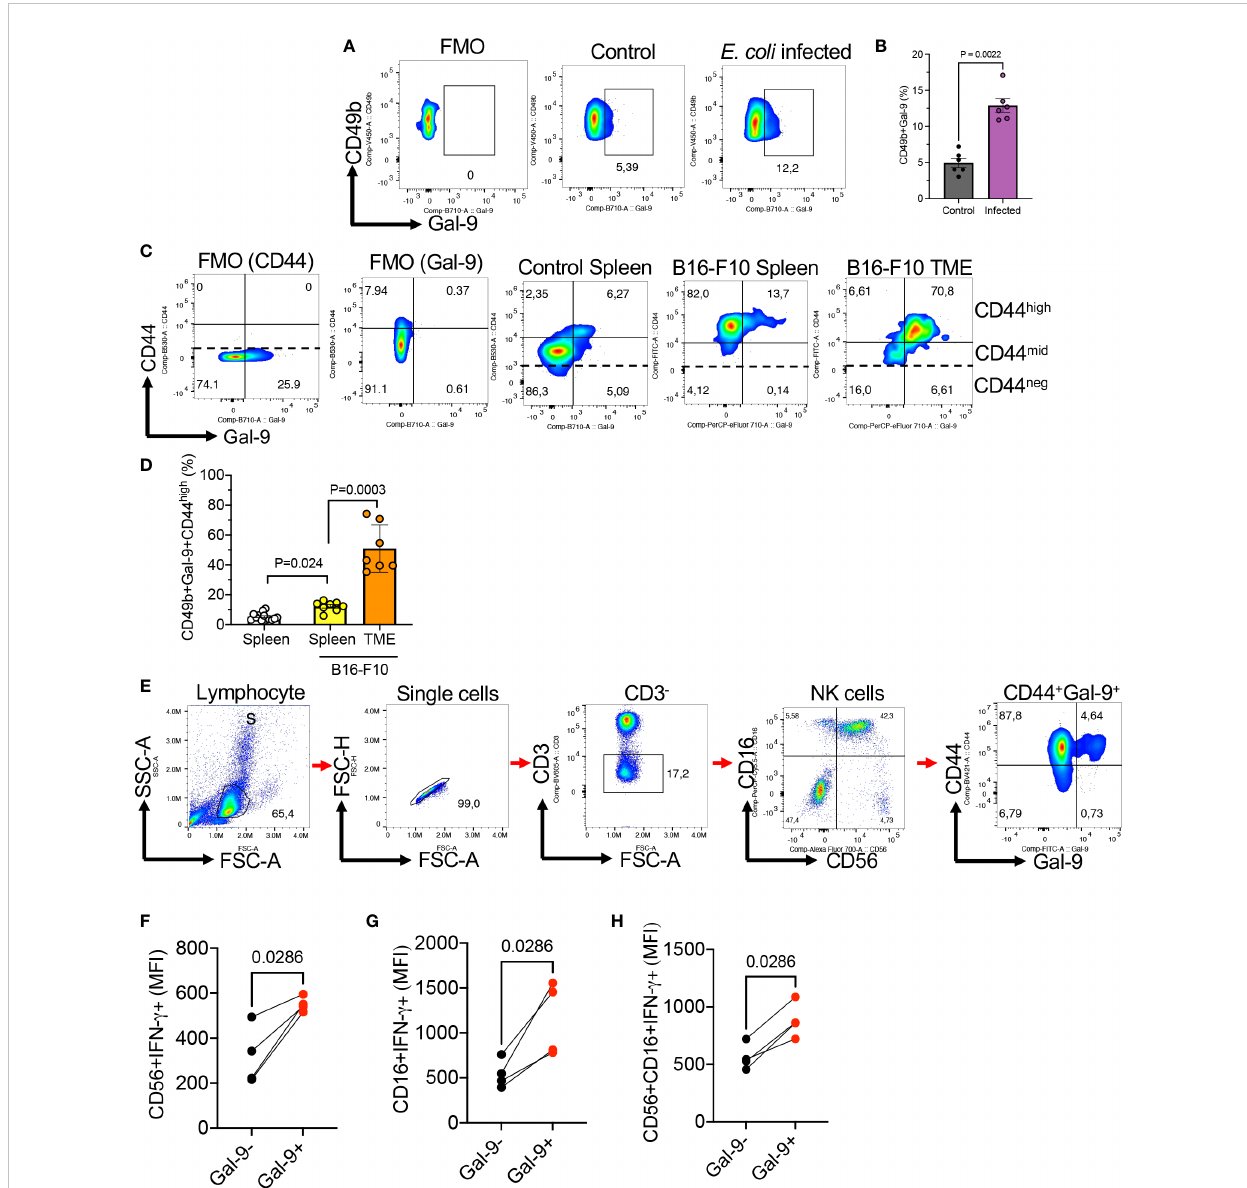
FIGURE 6 The expansion of Gal-9 + NK cells in the spleen and tumor tissues of B16-F10 melanoma model and the expansion of Gal-9 + NK cells in COVID-19 patients. (A) Representative fl ow cytometry plots, and (B) cumulative data of the frequency of NK cells in the spleen of control or infected adult mice with E . coli 48 hr post-infection. Each dot represents data from an animal. (C) Representative fl ow cytometry plots showing the co-expression of CD44 and Gal-9 in NK cells from the spleen of tumor naïve or the spleen and tumor microenvironment (TME) of tumor bearing mice (B16-F10 melanoma). (D) Cumulative data of the percentages of Gal-9 + NK cells in the spleen of tumor naïve or the spleen and TME of tumor-bearing mice. (E) Representative gating strategy for human Gal-9 + NK cells. (F) Cumulative data of IFN- g expression in Gal-9 + and Gal-9 - NK cells among CD56 + CD16 - , (G) CD16+CD56-, and (H) CD16 + CD56 + subset of human NK cells. Each dot represents data from an animal or human study subject. The mean fl uorescence intensity